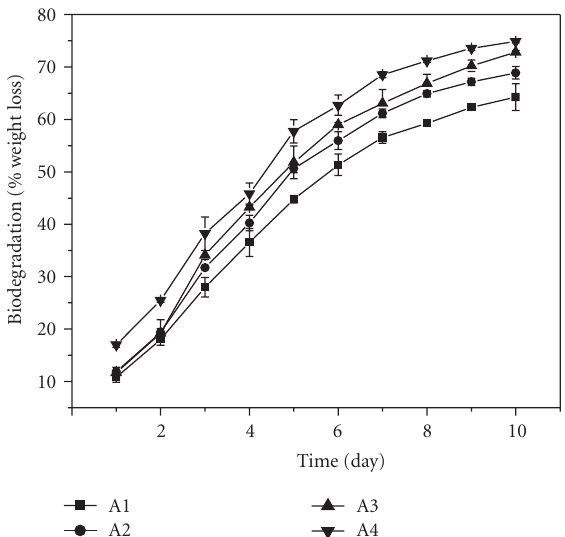
Figure 8: E ff ect of PLGA microsphere incorporation on biodegra- dation of gelatin sca ff old. Degradation was studied for 10 days by incubating the sca ff olds in PBS (pH-7.4) at 37 ◦ C. Values are mean ± S.D. ( n = 3). (A1) Gelatin sca ff old, (A2) 0.1%w/w PLGA microsphere loaded sca ff old, (A3) 1%w/w PLGA microsphere loaded sca ff old, and (A4) 10% w/w PLGA microsphere loaded sca ff old ∗ .